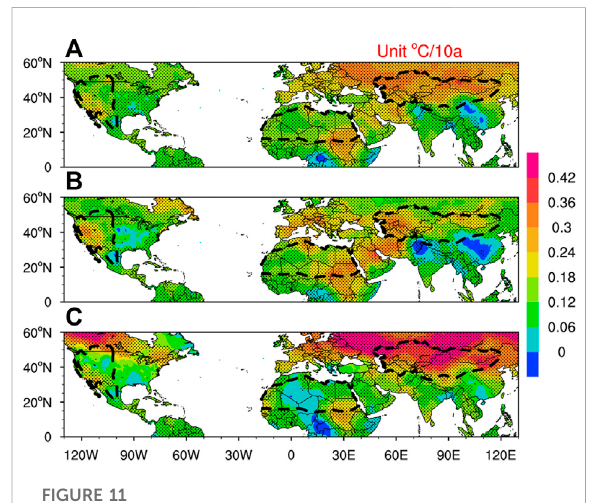
FIGURE 11 Variation rates of temperature in (A) annual, (B) warm season and (C) cold season from 1941 to 2020. The dashed lines outline the study region, and the shaded areas indicate the values passing the signi fi cance test at the 95% con fi dence level.